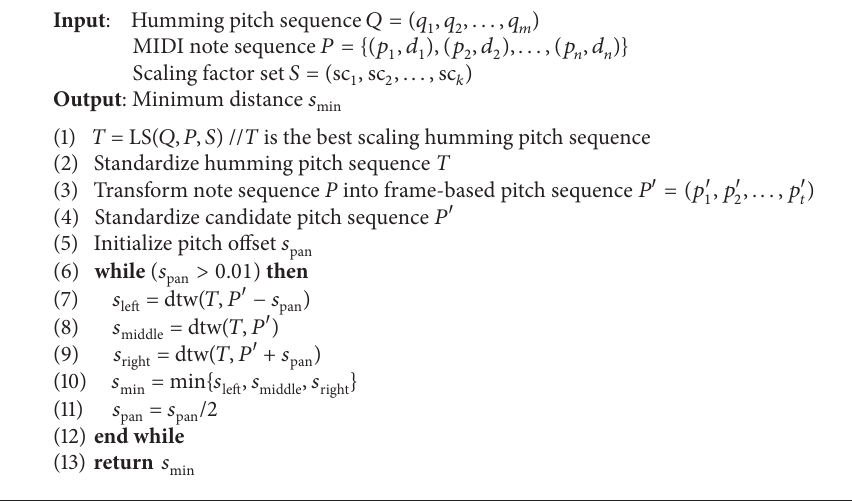
Algorithm 1: DTW-based match ( 𝑄,𝑃, 𝑆